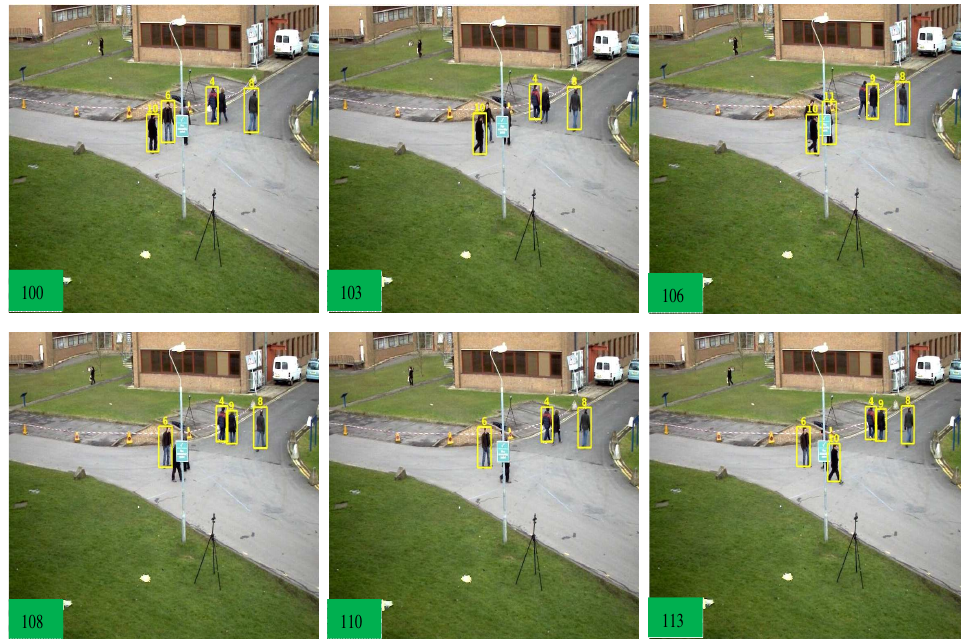
Figure 5. Effectiveness of our tracker in the occlusion case-1. As from the above frames, an object with the ID (10) is passing behind the pole and from frame number 103 to 110, it has no detection response due to occlusion. Our tracker re-assigns that object with the same ID (10) at frame